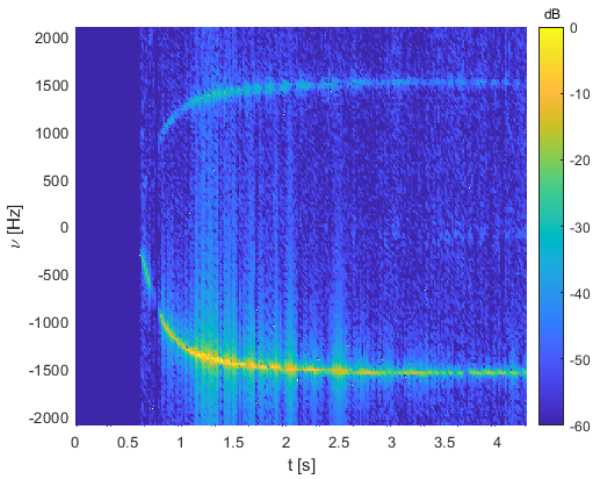
Figure 25. Evolution of the Doppler spectrum of the main delay component.